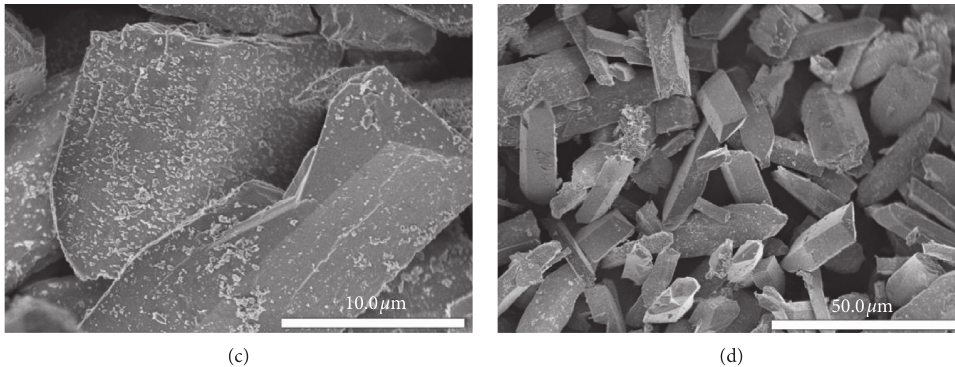
Figure 2: SEM images with different magnifications of the MIL-53 samples: the FeCl